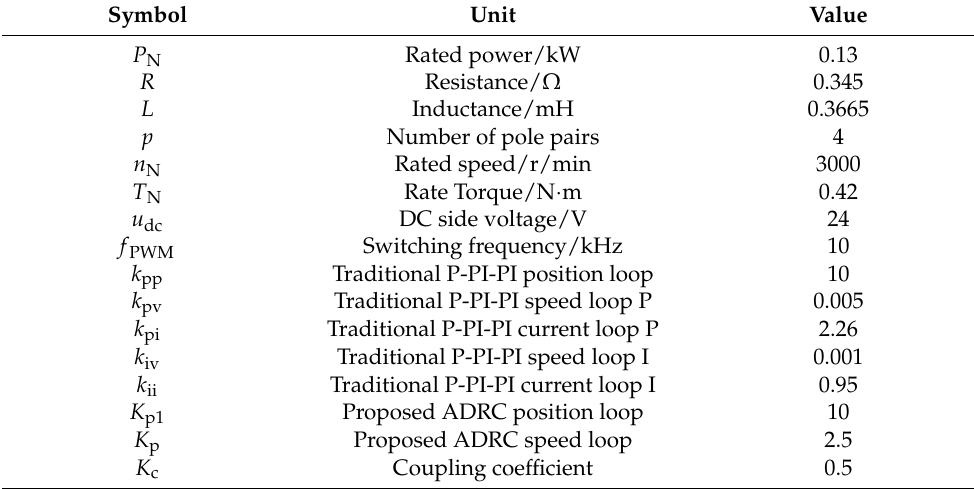
Figure 11. Dual PMSM system experimental platform. Table 1. The parameters of PMSM-driven servo system and controller.